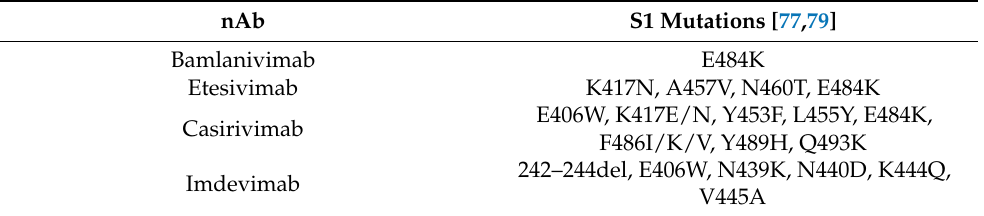
Table 3. Spike Amino Acid Substitutions in SARS-CoV-2 That Reduce Binding of nAbs with Food and Drug Administration Emergency Use